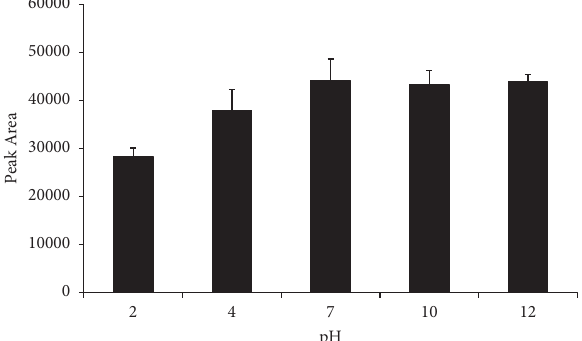
Figure 9: Effect of sample pH on extraction efficiency. Extraction conditions: PVC nanostructured membrane as sorbent material, ex- traction time 20min, desorption time 25min with 0.01M sulfuric acid as the desorption solvent, and sample volume 5 mL.